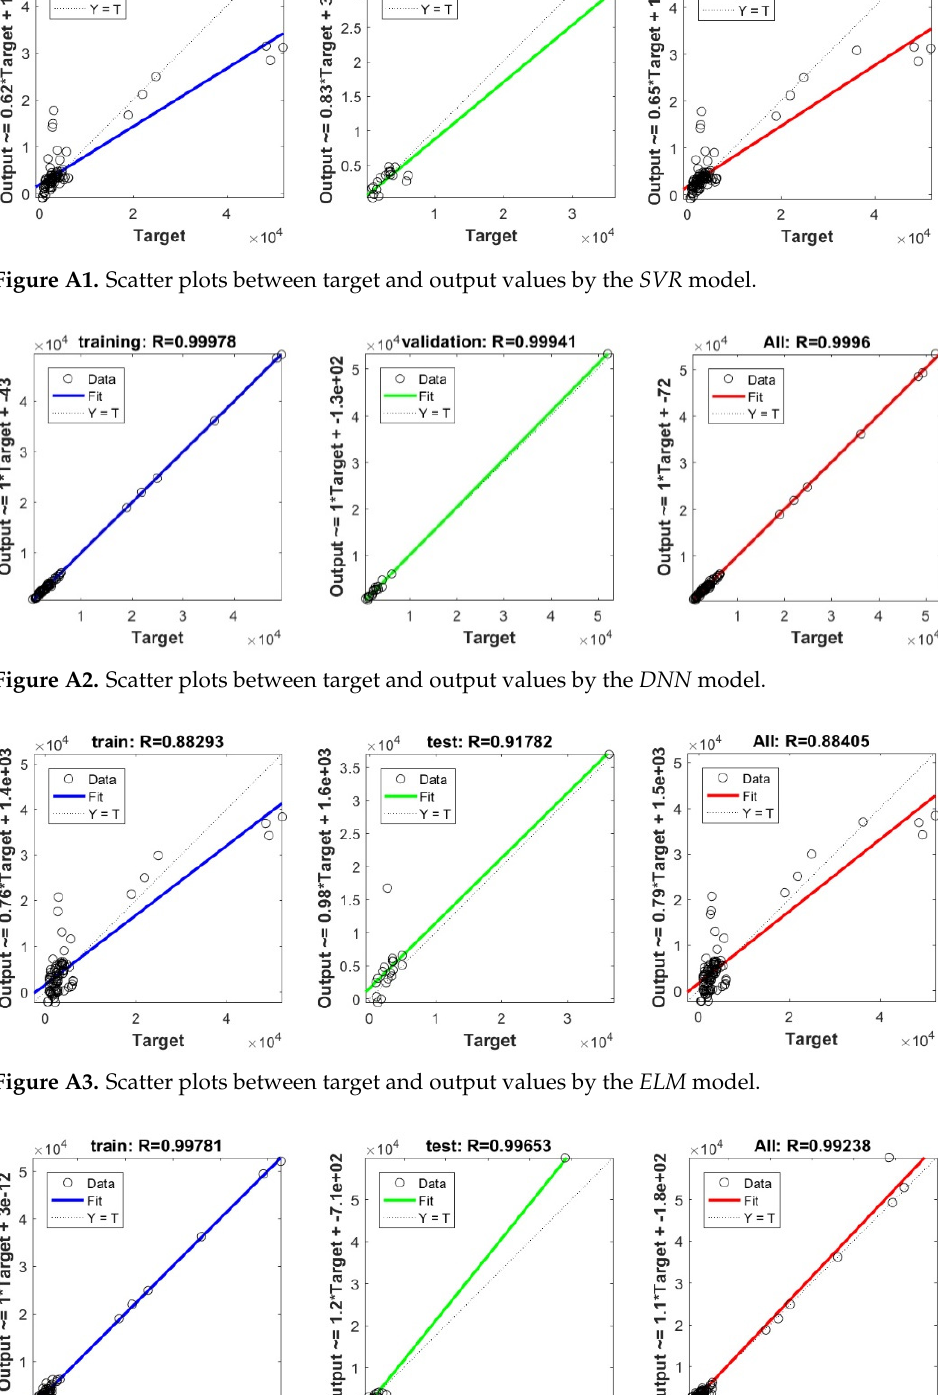
Figure A5. Scatter plots between target and output values by the KRidge model.